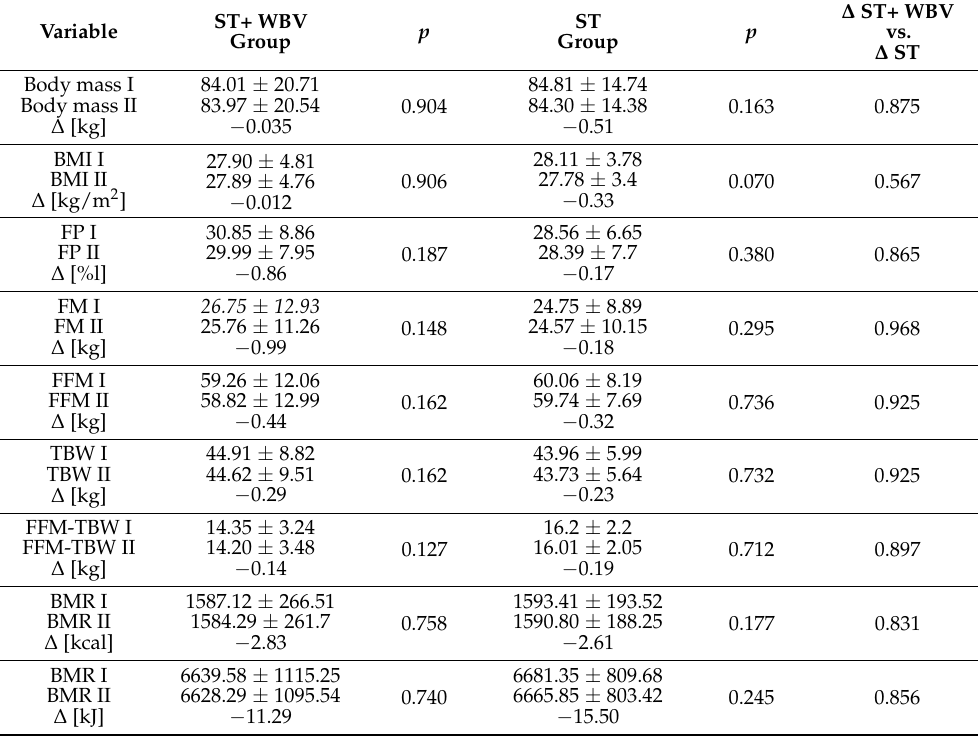
Table 6. Results of the body mass composition